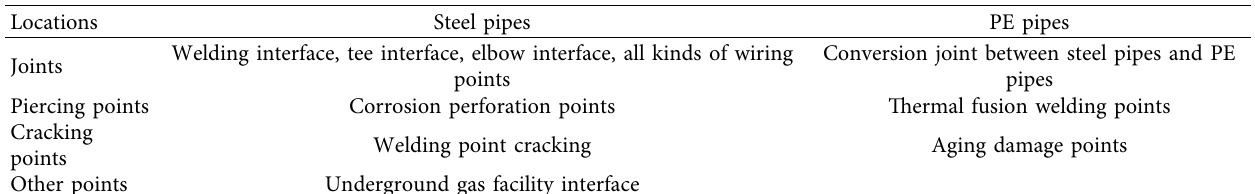
Table 2: Distributions of main leakage points for steel and PE pipes.